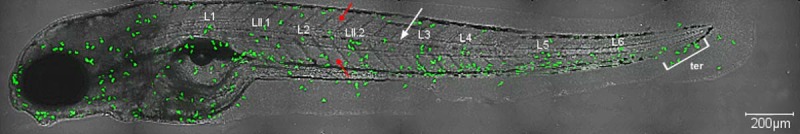
A photograph illustrating the neutrophil counting area.5 dpf Tg(MPX:GFP) transgenic zebrafish larvae after 40 min exposure to 10 µM CuSO4 presents the area were neutrophils were quantified (green dots; in the intact larvae only single neutrophils were observed). Both neutrophils associated with investigated neuromasts (L1, LII.1, L2, LII.2, L3, L4, L5 and L6) as well as those which did not adhere directly to the neuromasts (but were sparsely found within the area encircled by the notochord [white arrow]) were counted. Dorsal and ventral myotomes marked with red arrows and terminal neuromasts (ter) were excluded from the analysis. The larvae carried myeloperoxidase promoter driving the expression of green fluorescent protein (GFP) in myeloid leukocytes (mostly neutrophils). The visualization was accomplished using a Zeiss LSM-700 confocal microscope.